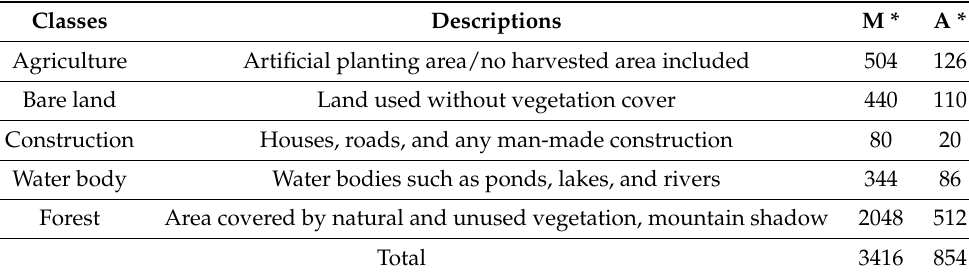
Table 1. Number of samples of modeling and application testing datasets.